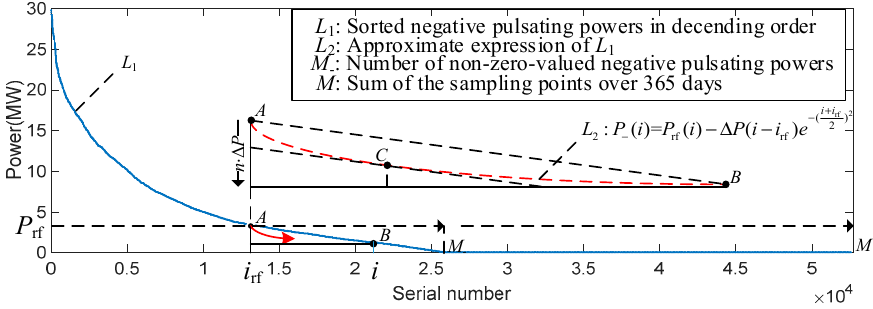
Figure 4. The distribution map of the sorted negative pulsating power in descending order.